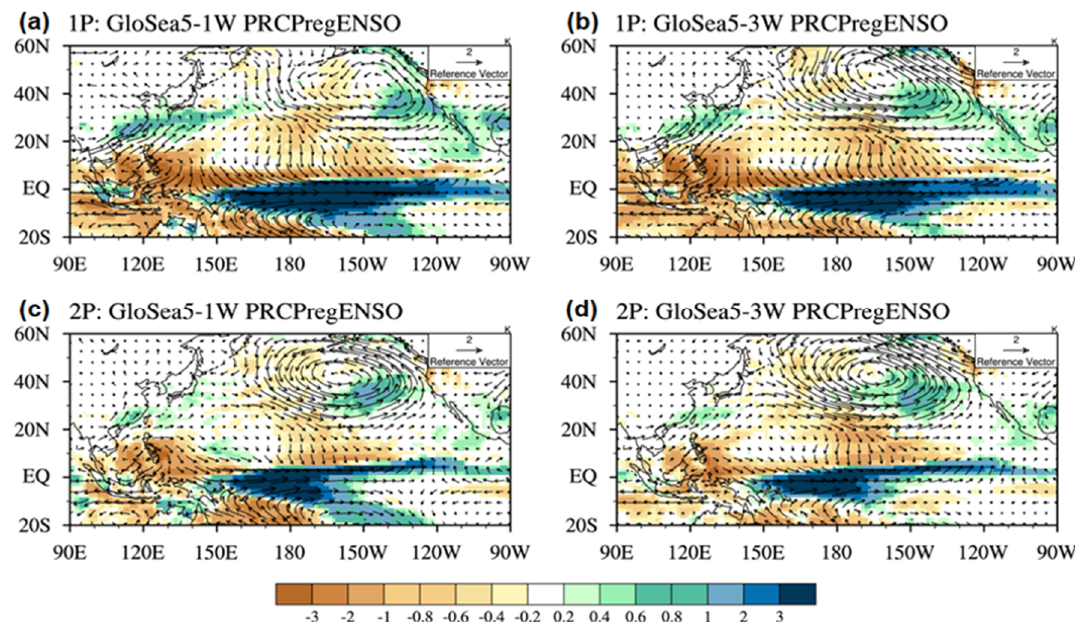
Figure 11. Surface precipitation (shaded) and 850 hPa wind (vectors) regressed onto the Nino 3.4 index from GloSea5 ( a ) and ( c ) with a lead time of 1 week, and ( b ) and ( d ) with a lead time of 3 weeks. In ( a ) and ( b ) 1P is averaged for 1991–1999, and in ( c ) and ( d ) 2P is averaged for 2001–2009.